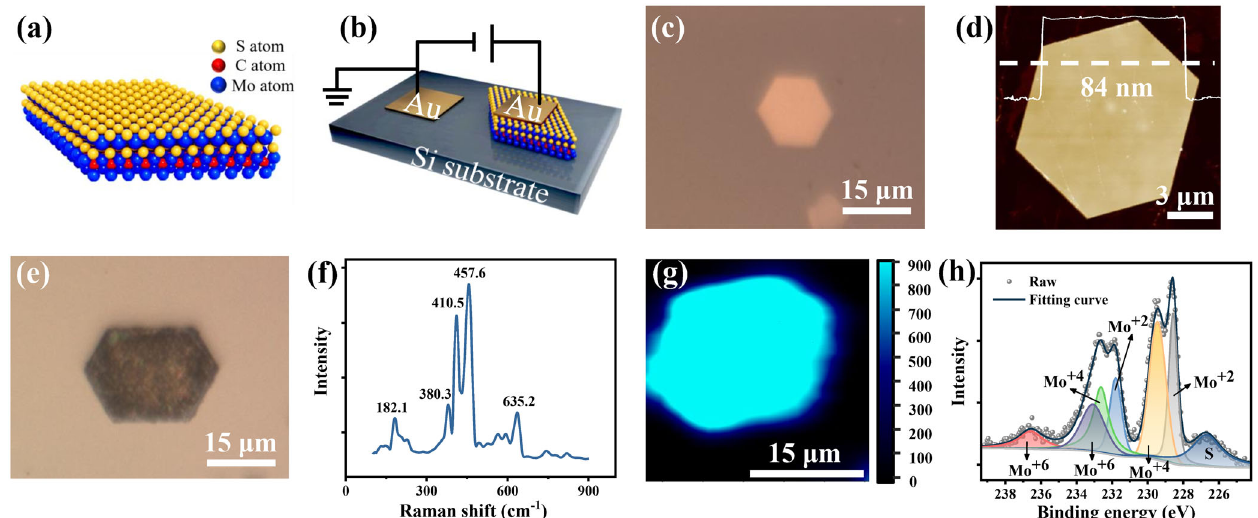
Fig. 1 Structure characteristics of the 2D Mo 2 C/MoS 2 heterostructure. a Schematic illustration of the Mo 2 C/MoS 2 heterostructure. b Schematic illustration of the measurement of the electrical properties of the device, where Ni/Au electrodes are deposited on the surface of MoS 2 and Si substrate, respectively. c OM, and d AFM image of the as grown 2D Mo 2 C crystal. e OM, f Raman spectra, g Raman mapping of the intensity at the peak of 410.5 cm − 1 , and h XPS of the 2D Mo 2 C/MoS 2